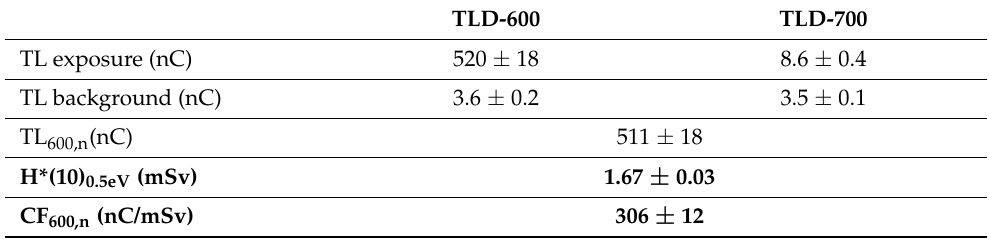
Table 1. Measured signal of thermoluminescent dosimeters (TLD-600 and TLD-700), neutron thermal dose equivalent (H*(10) 0.5eV ), and calibration factor for TLD ‐ 600.